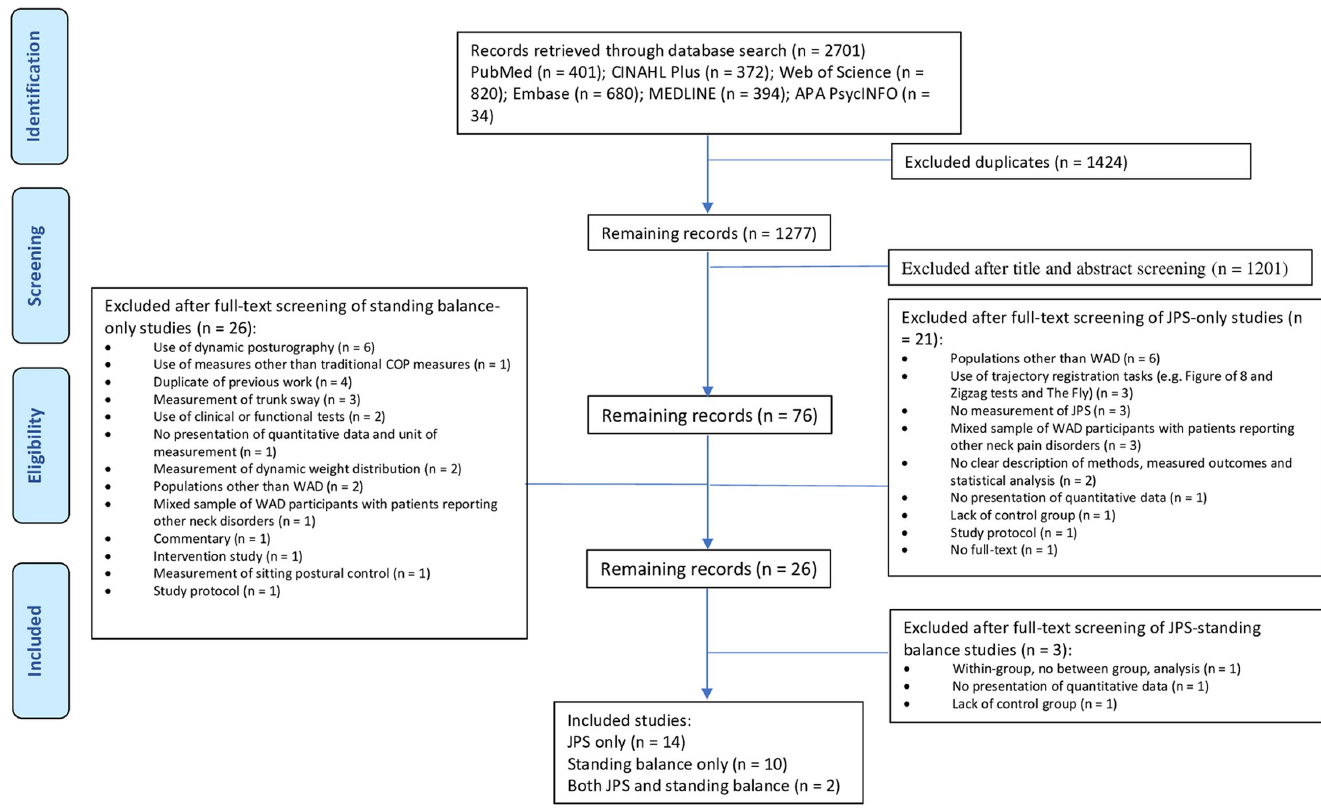
Fig 1. Flowchart of study